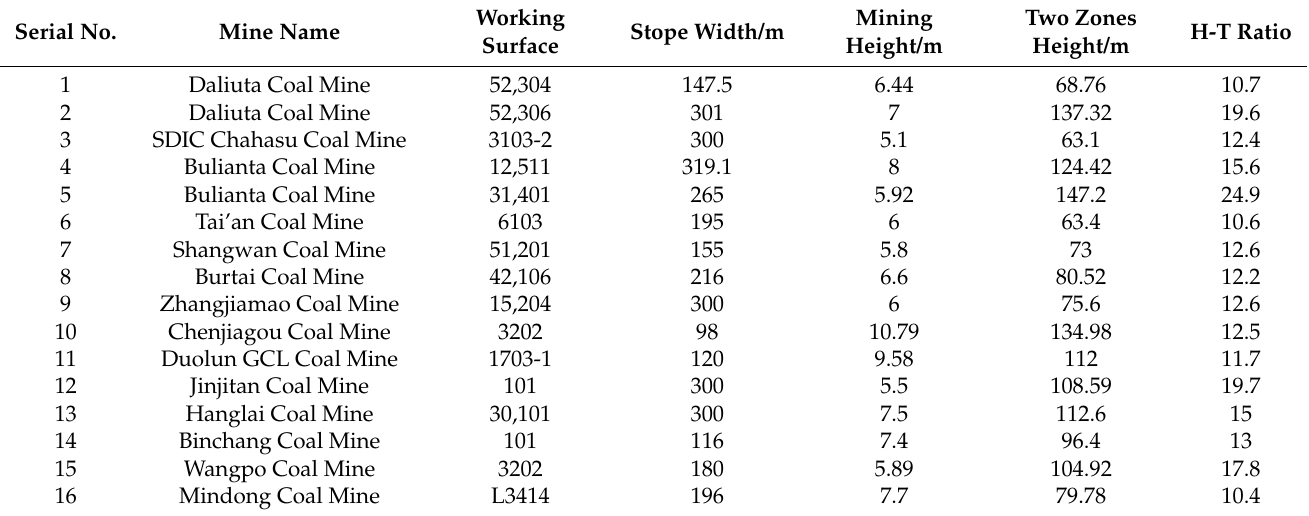
Table 5. Height data of water-conducting fracture in the western mining.